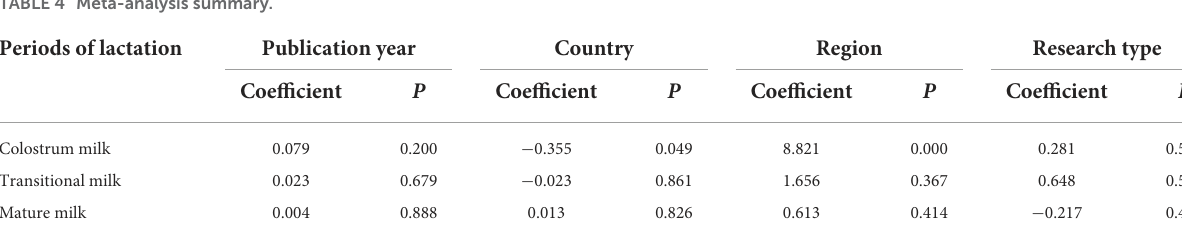
TABLE 4 Meta-analysis